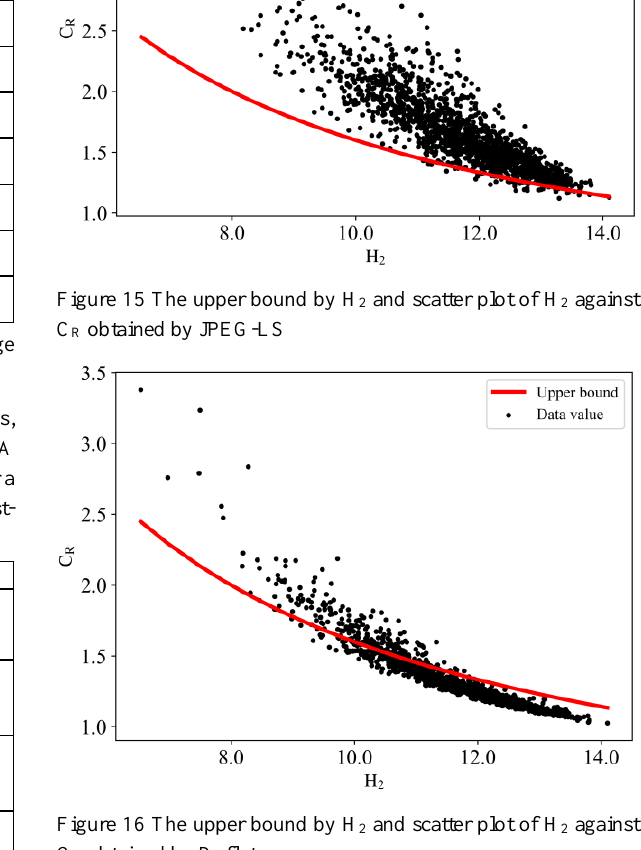
Figure 16 The upper bound by H 2 and scatter plot of H 2 against C R obtained by